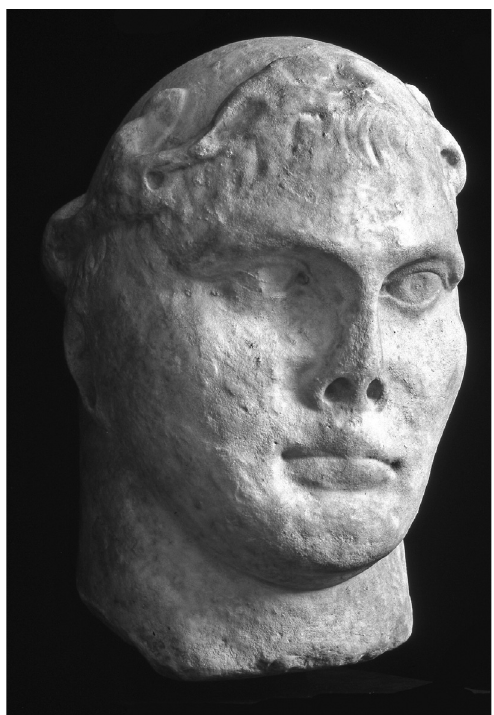
Figure 2: ‘Constantine’ head from the Yorkshire Museum (York Museums